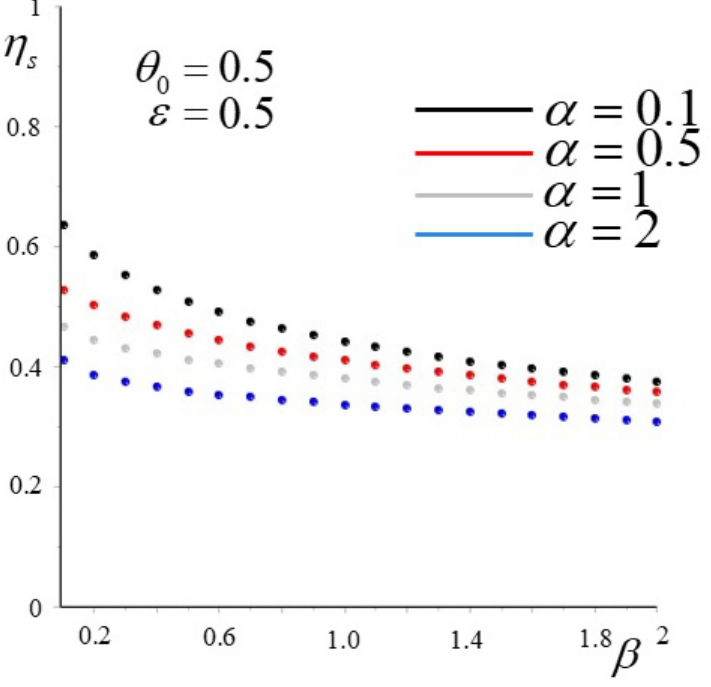
Figure 4. The plot of efficiency η s as a function of β for four different values of α and for θ 0 =